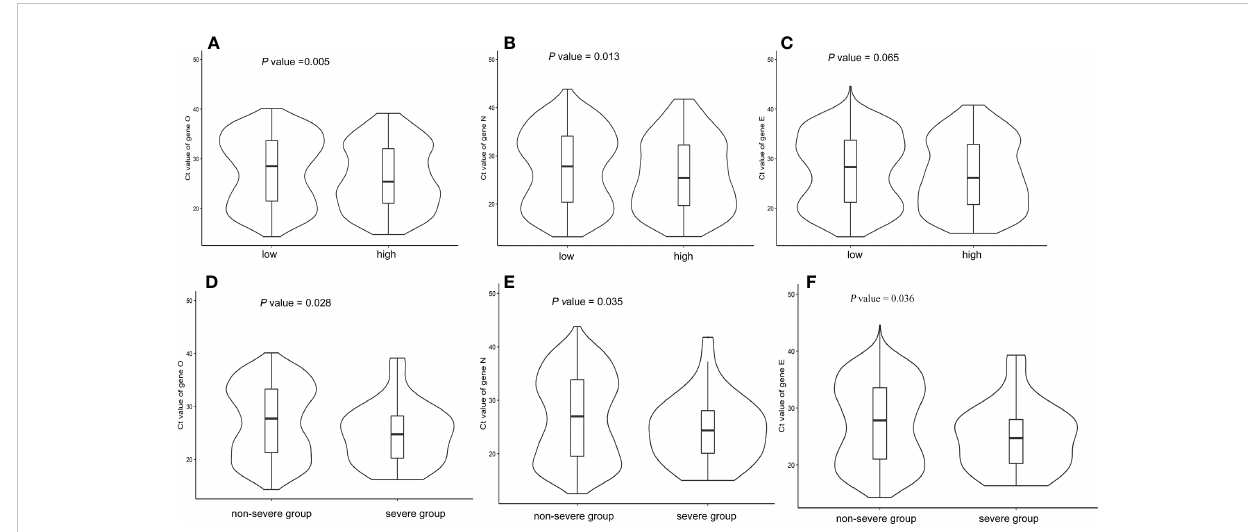
FIGURE 1 Boxviolin plots of Ct values. (A – C) : Distributions of Ct values for target genes according to the burden of comorbidity. (D – F) : Distributions of Ct values for target genes according to disease severity. P values were calculated by a two-tailed Mann – Whitney test between groups.